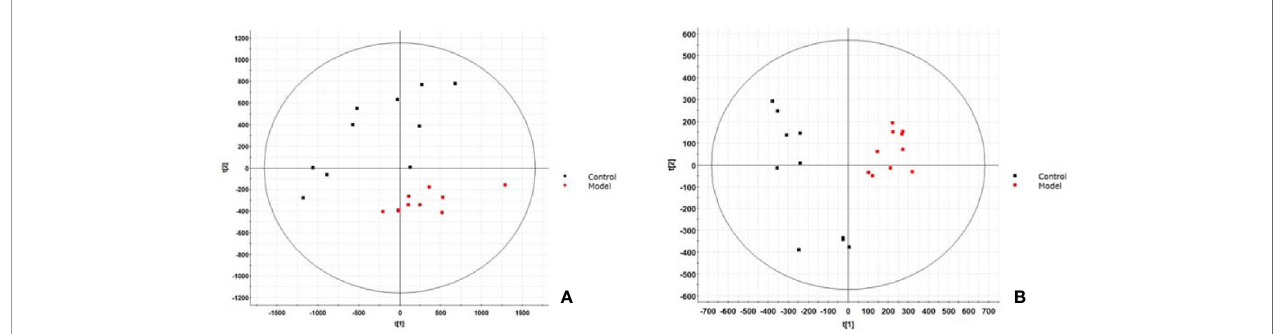
FIGURE 1 | Score plot of serum pro fi le of control group and model group scanned by principal component analysis (PCA) analysis. (A) Positive ion mode. (B) Negative ion mode.